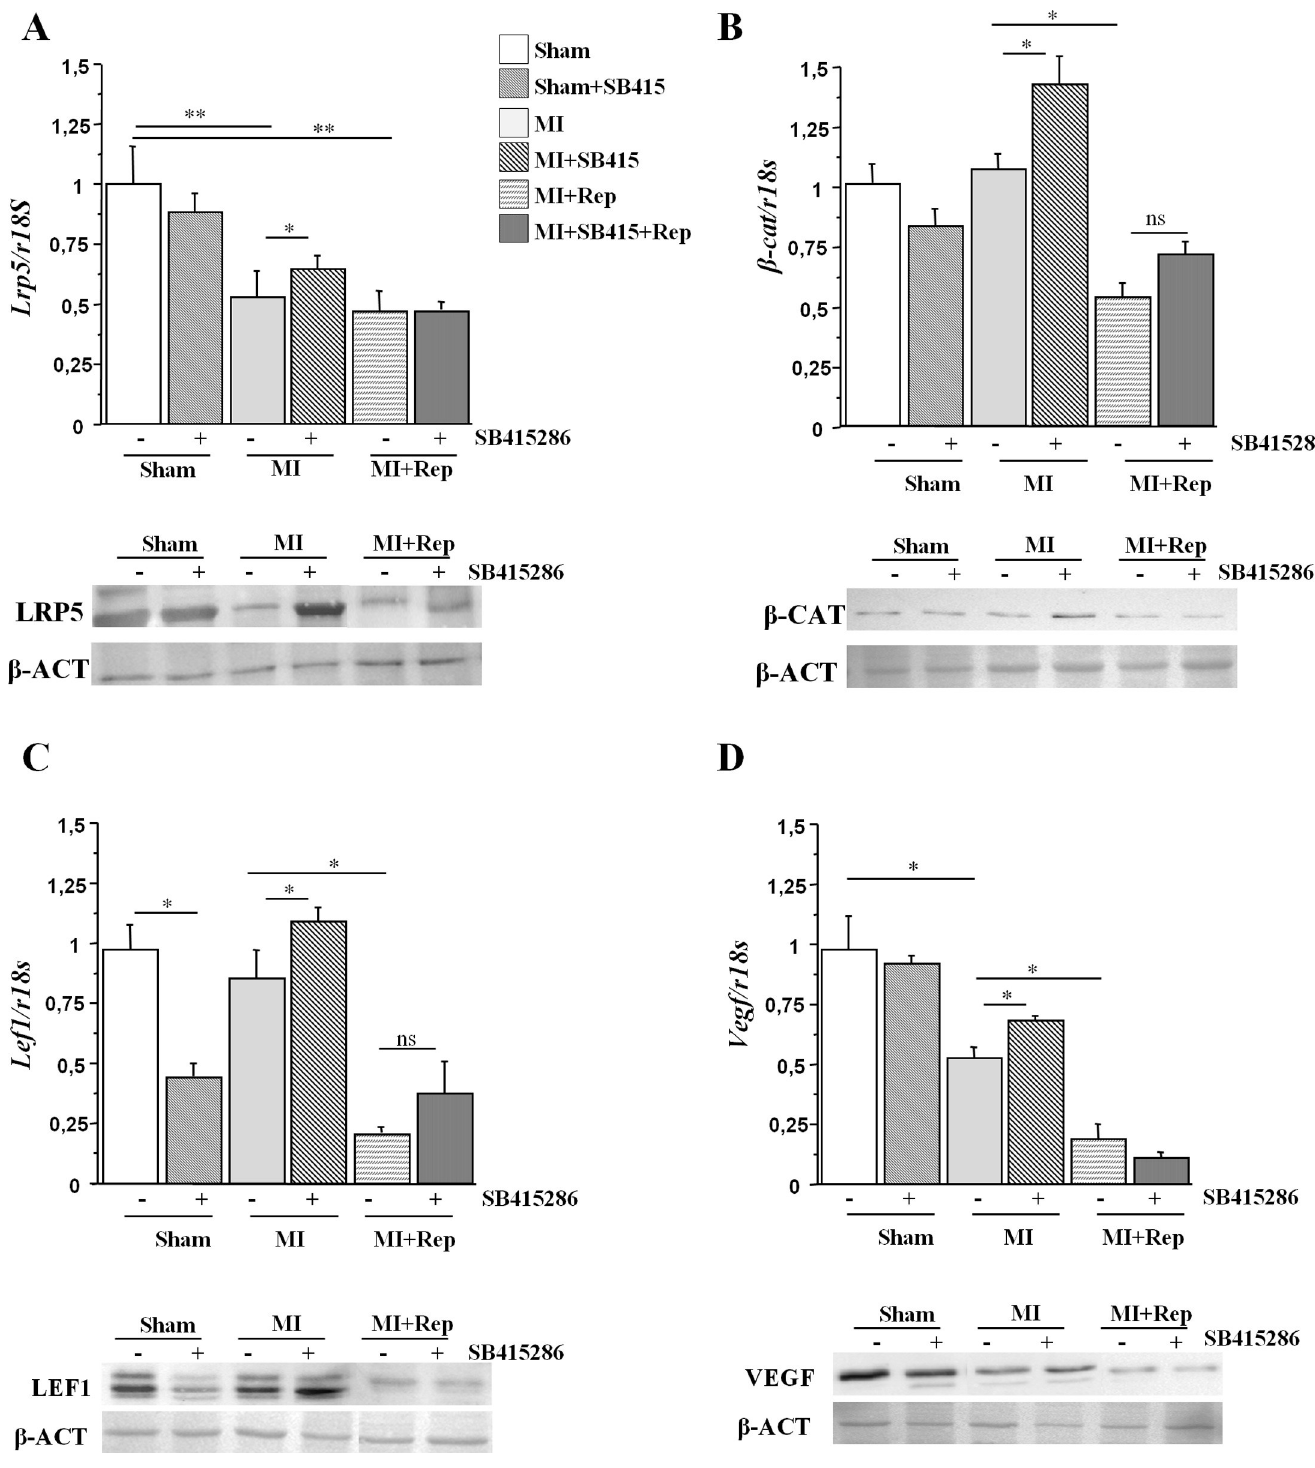
Fig 4. Canonical Wnt signaling protein expression in hearts of Wt mice after reperfusion. mRNA expression levels and representative images of protein expression levels of (A) Lrp5 , (B) β -catenin , (C) Lef1 and (D) Vegf in hearts of Wt mice after 90 minutes reperfusion in the presence or absence of SB415286. 6–10 mice /condition � p < 0,05; �� p < 0,01; ��� p < 0,005; ns = non significant.